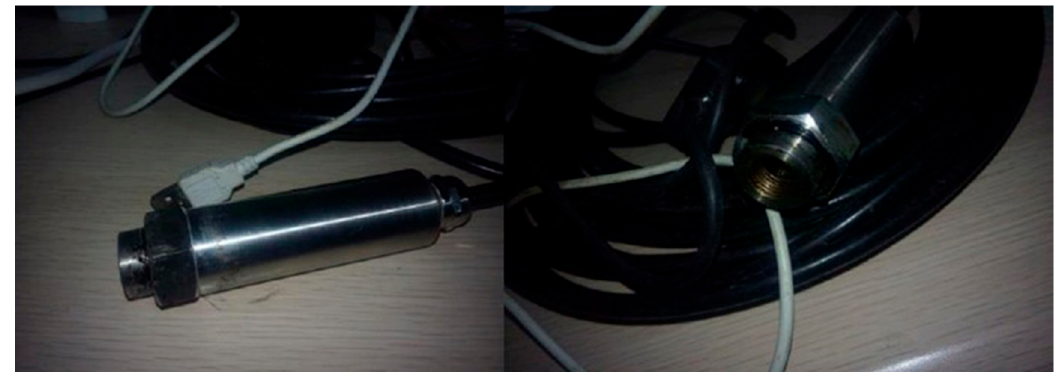
Figure 2. Shape of